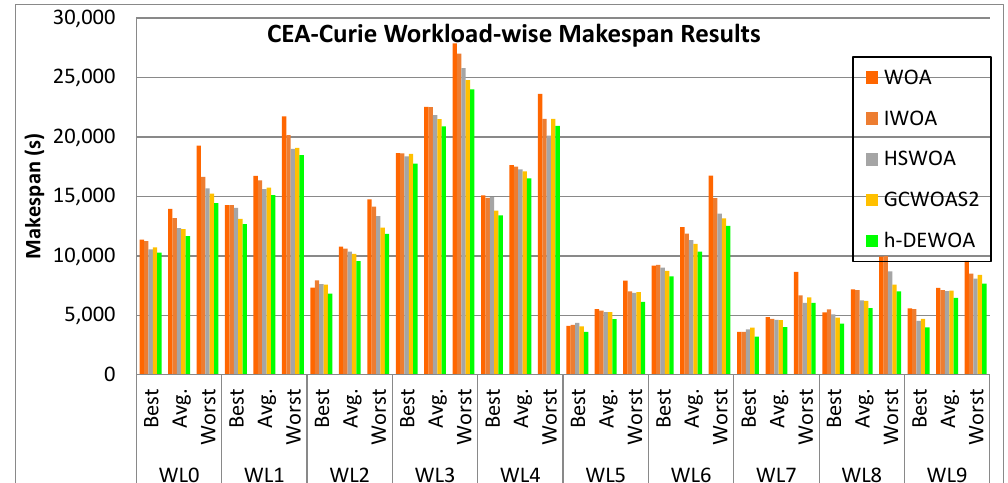
Figure 7. Statistical results of the makespan metric for WL0 – WL9 workloads. Workload-Wise Energy Consumption Results for CEA-Curie Workloads Figure 8 indicates that the h-DEWOA algorithm produces the minimum best, aver- age, and worst values of the energy consumption in a majority of CEA-Curie workloads.